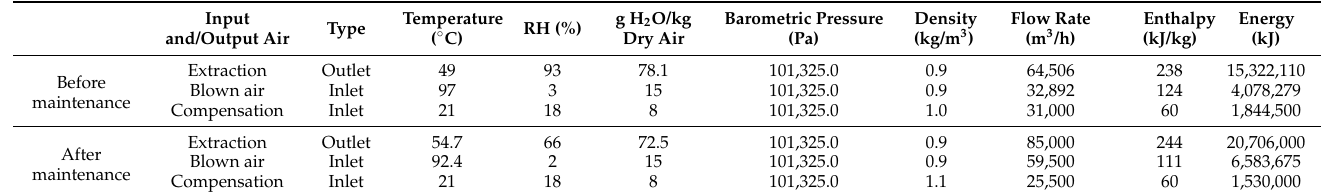
Table 1. Data of air before and after the repair of the